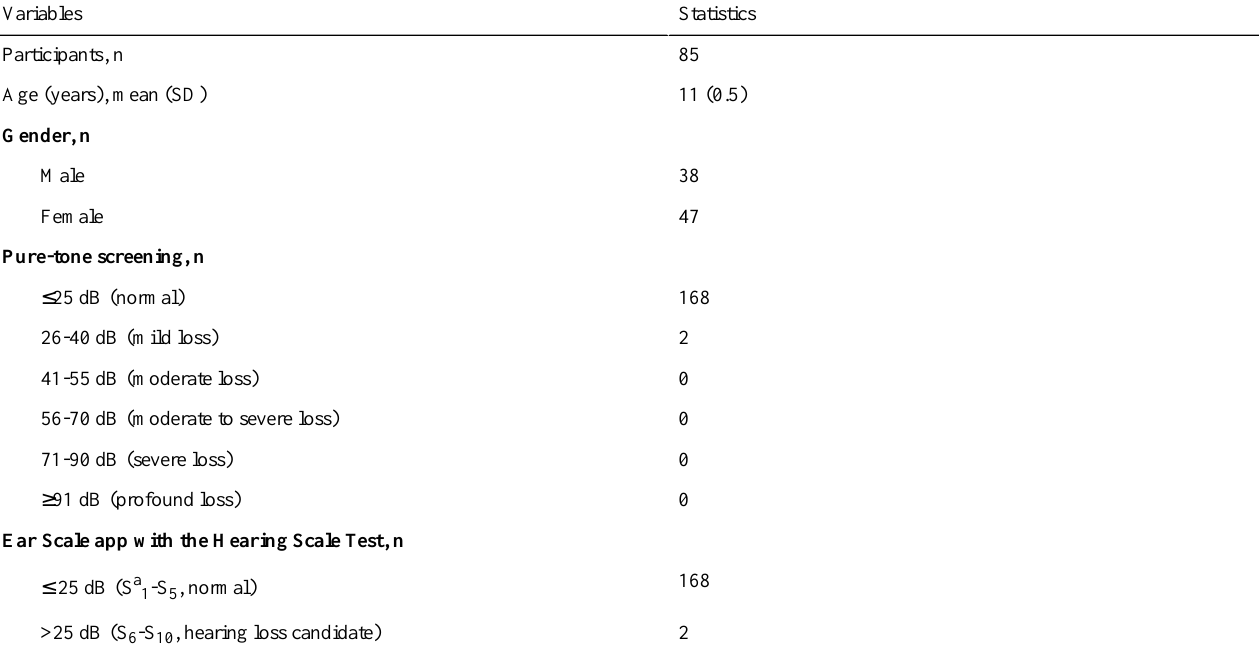
Table 2. Participants’demographics and hearing impairment candidacy (as graded by the pure-tone screening and Hearing Scale Test).